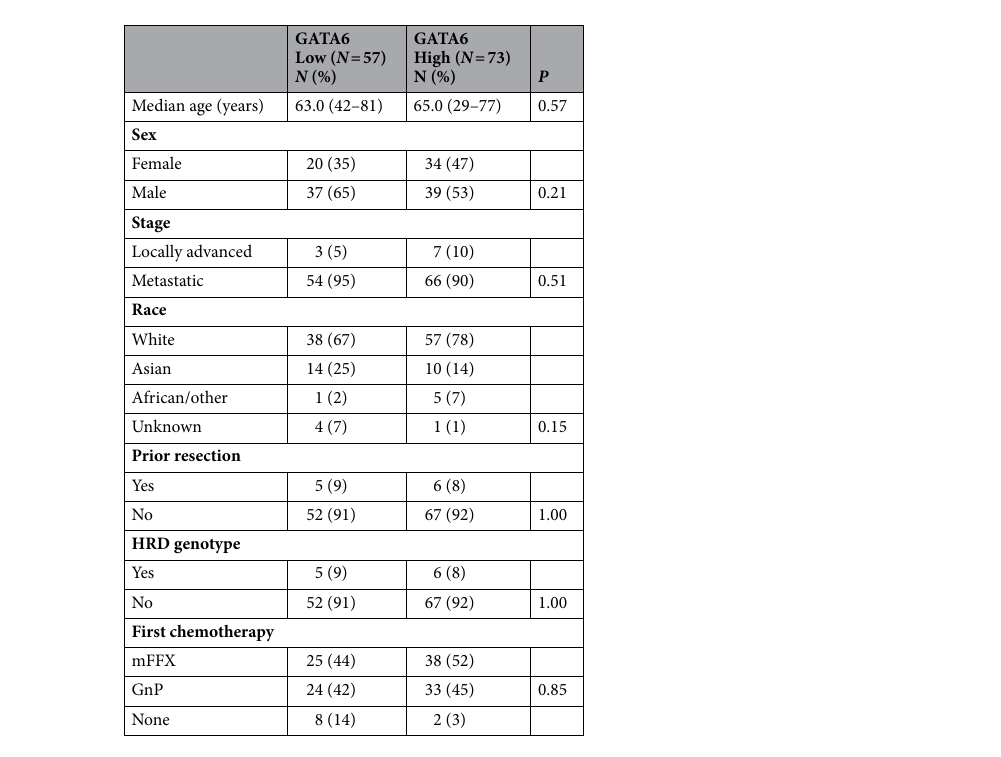
Table 1. Patient characteristics according to GATA6 IHC expression (n = 130). GnP gemcitabine– nabpaclitaxel, mFFX modified FOLFIRINOX.